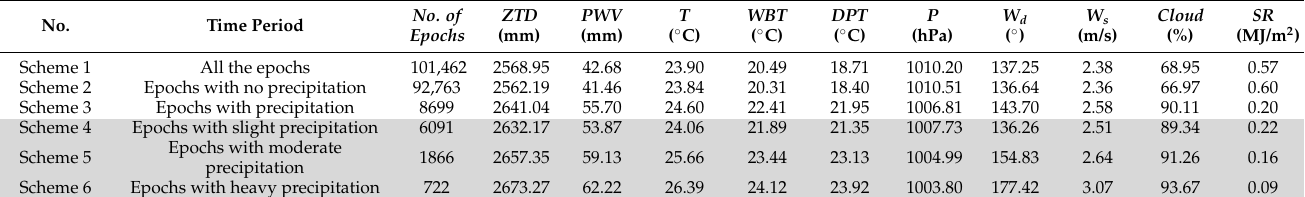
Table 6. Mean values obtained under different precipitation circumstances over the period